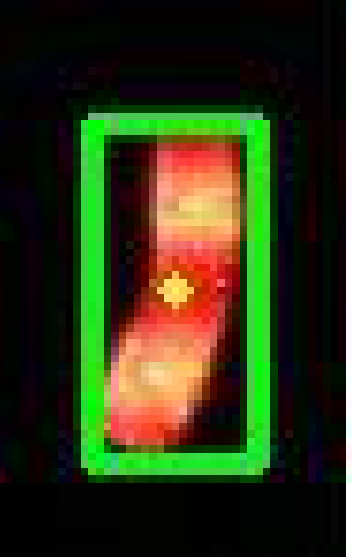
Figure 8. Example of a minimum bounding